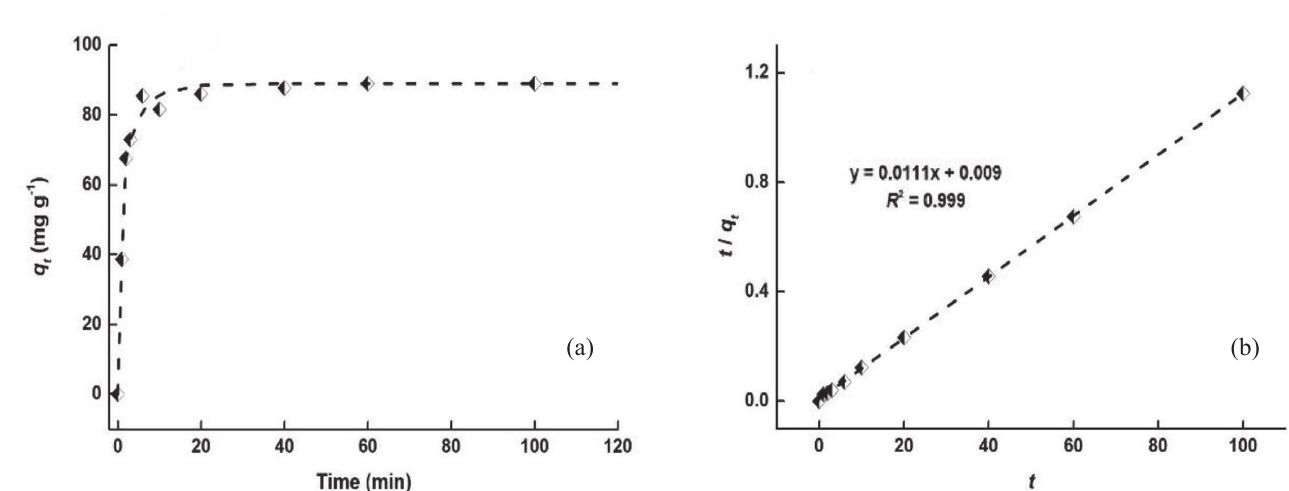
Fig. 6 – (a) Effect of contact time on adsorption of HA onto Co-MOF (pH = 6, adsorbent dosage = 25 mg, volume = 0.05 L, HA initial concentration = 50 mg L –1 , temperature = 305 K) (b) pseudo-second-order plot with experimental